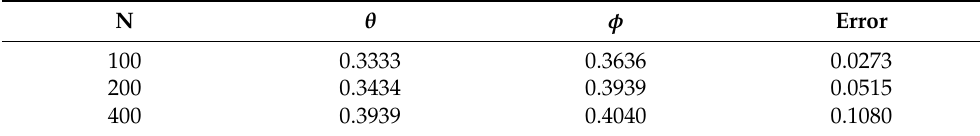
Table 3. The optimal parameters θ and φ in convex combination and the sum of the corresponding error.